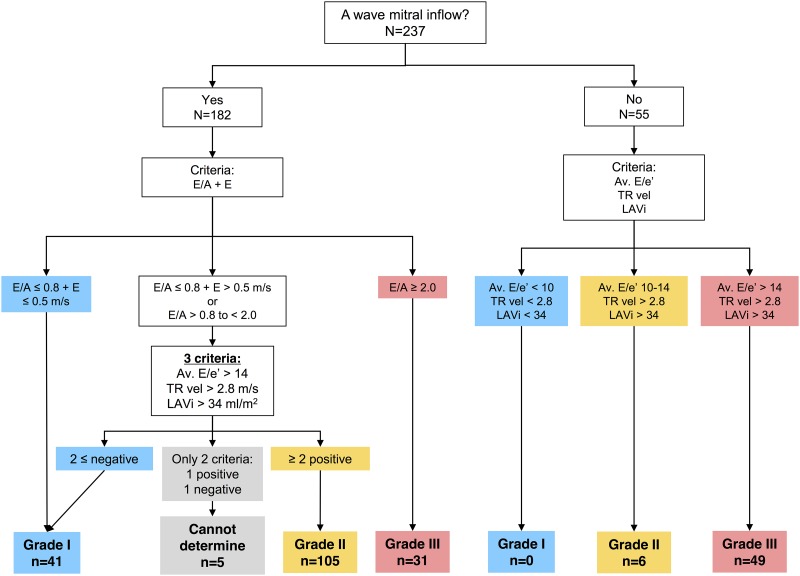
Flow diagram for the evaluation of diastolic dysfunction by ASE/EACVI 2016 Recommendations.Patients were classified as grade I, II, or III diastolic dysfunction or “cannot determine” category. Abbreviations: TR, tricuspid regurgitation; LAVi, left atrial volume index; Av E/e’, ratio between mitral inflow E velocity and the average of septal and lateral mitral e’.